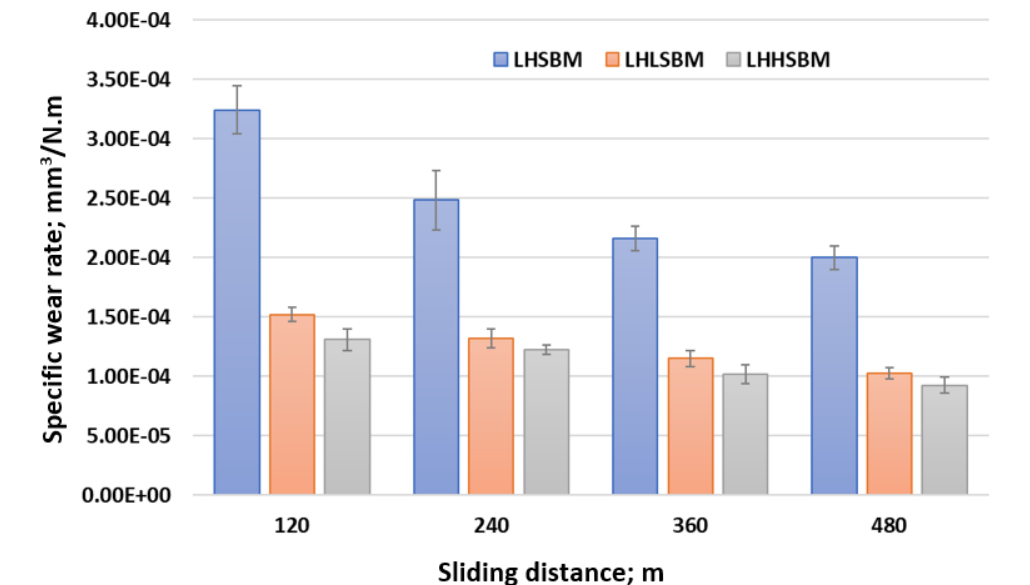
Figure 21. The specific wear rate of Al/SiC composites.